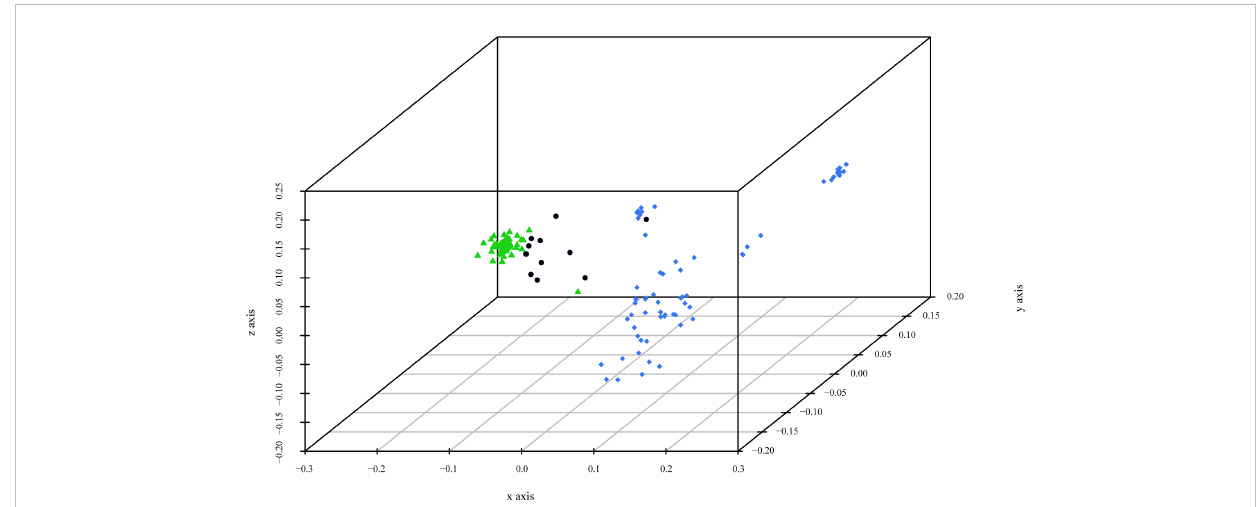
FIGURE 3 3D graph of Principal Coordinate Analysis (PCoA) based on polymorphism at 11 SSR loci of the 124 genotypes. The colors of the accessions indicate the most relevant parameter K = 2: green for P. cerasifera accessions, blue for mainly P. domestica material, and black for admixed accessions.